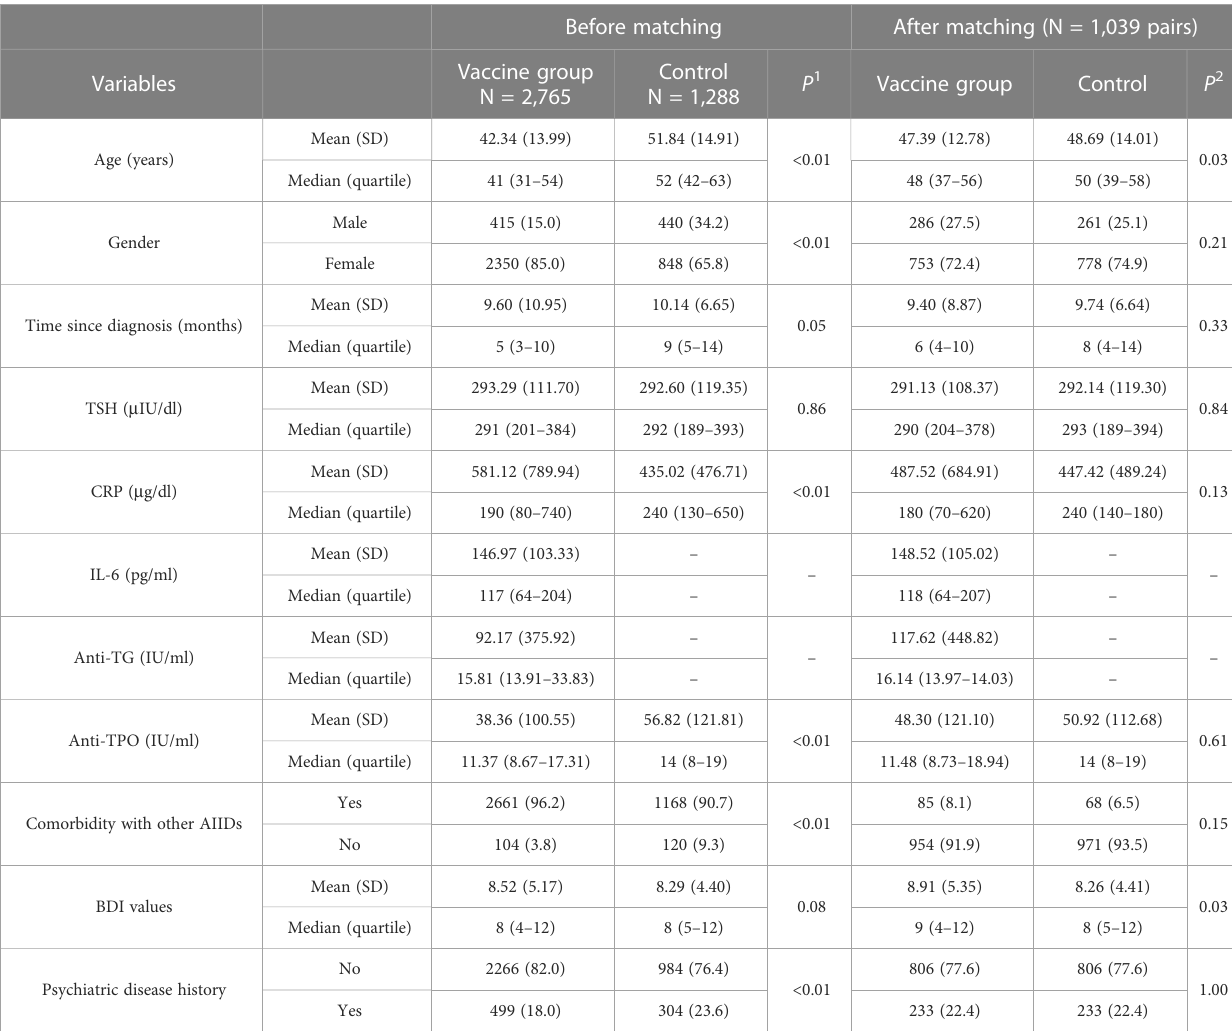
TABLE 1 Baseline variables of patients with Hashimoto